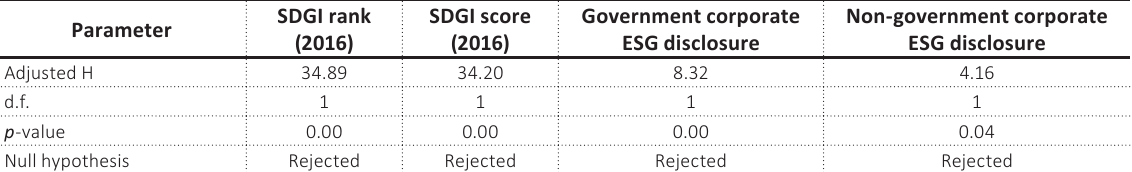
Table C3. Mann-Whitney U test of the differences between developed countries and emerging countries SDGI rank Parameter